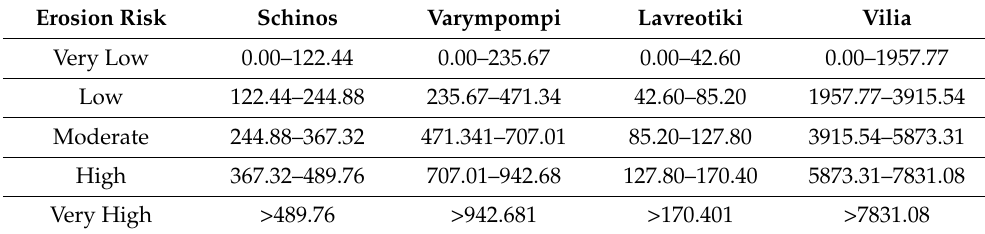
Figure 8. Erosion risk according to RUSLE soil loss for Vilia burned area: ( a ) before the fire; ( b ) after the fire. The erosion risk as classified is presented including the percentage of the burned area total of each area per class. Table 5. Erosion risk classification for RUSLE soil loss (ton/ha/season), presenting each class for each